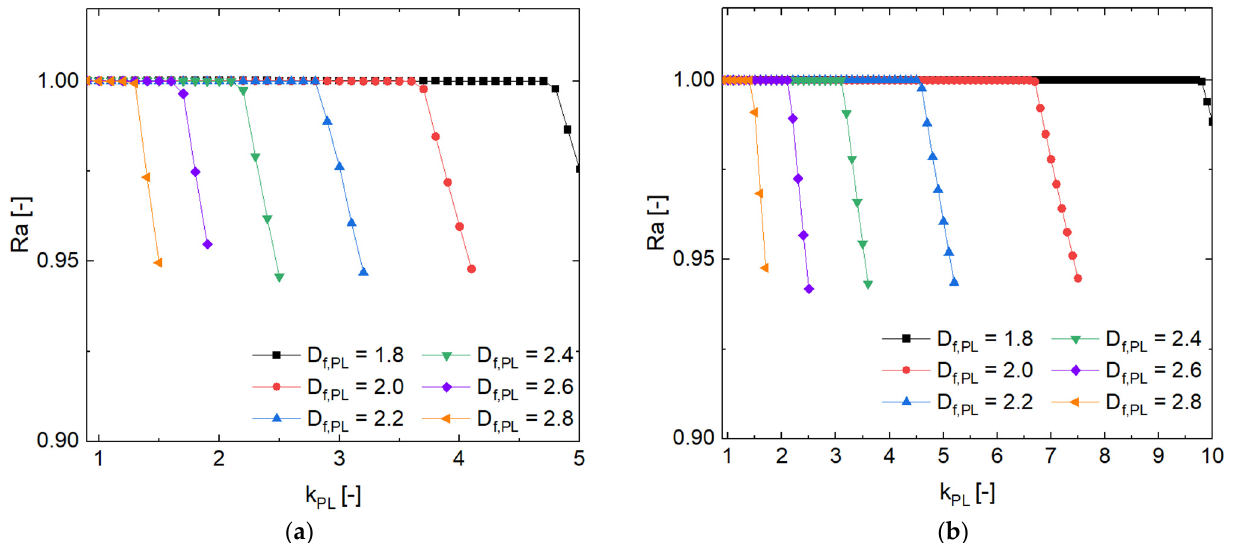
Figure 5. Influence of k PL and D f , PL on Ra for different N p , ( a ) N p = 50, ( b ) N p = 300.